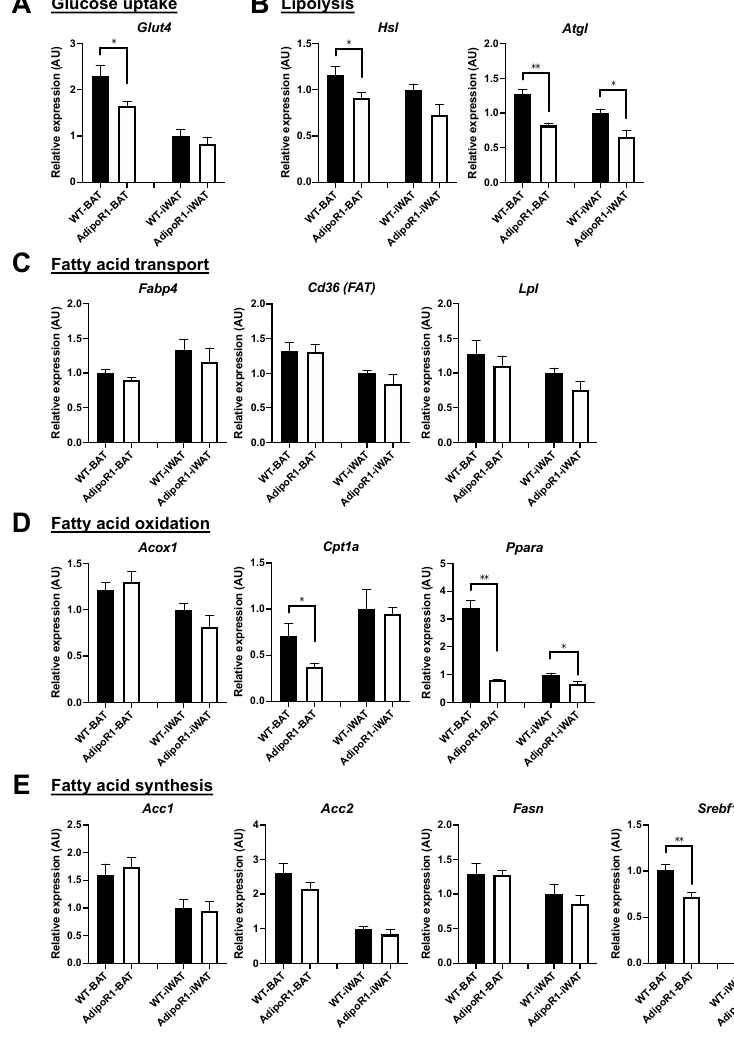
Figure 8. Reduced expression of glucose uptake, lipolysis, and fatty acid oxidation in classical brown and beige adipose depots of AdipoR1 mice after cold-stimulation. Gene expression related to ( A ) glucose uptake, ( B ) lipolysis, ( C ) fatty acid transport, ( D ) fatty acid oxidation, and ( E ) fatty acid synthesis was evaluated in indicated adipose tissues of WT and AdipoR1 female mice following cold exposure. Timeline and procedures were described in Figure 1. Classical iBAT and iWAT (the potential white adipose depot for browning or beiging) in WT and AdipoR1 female mice were harvested, extracted, and measured to evaluate adipose metabolism genes ( n = 3–8 for each group). Data were presented as relative means (normalized to β -actin in arbitrary units, AU) ± SEM. * p ≤ 0.05; ** p ≤